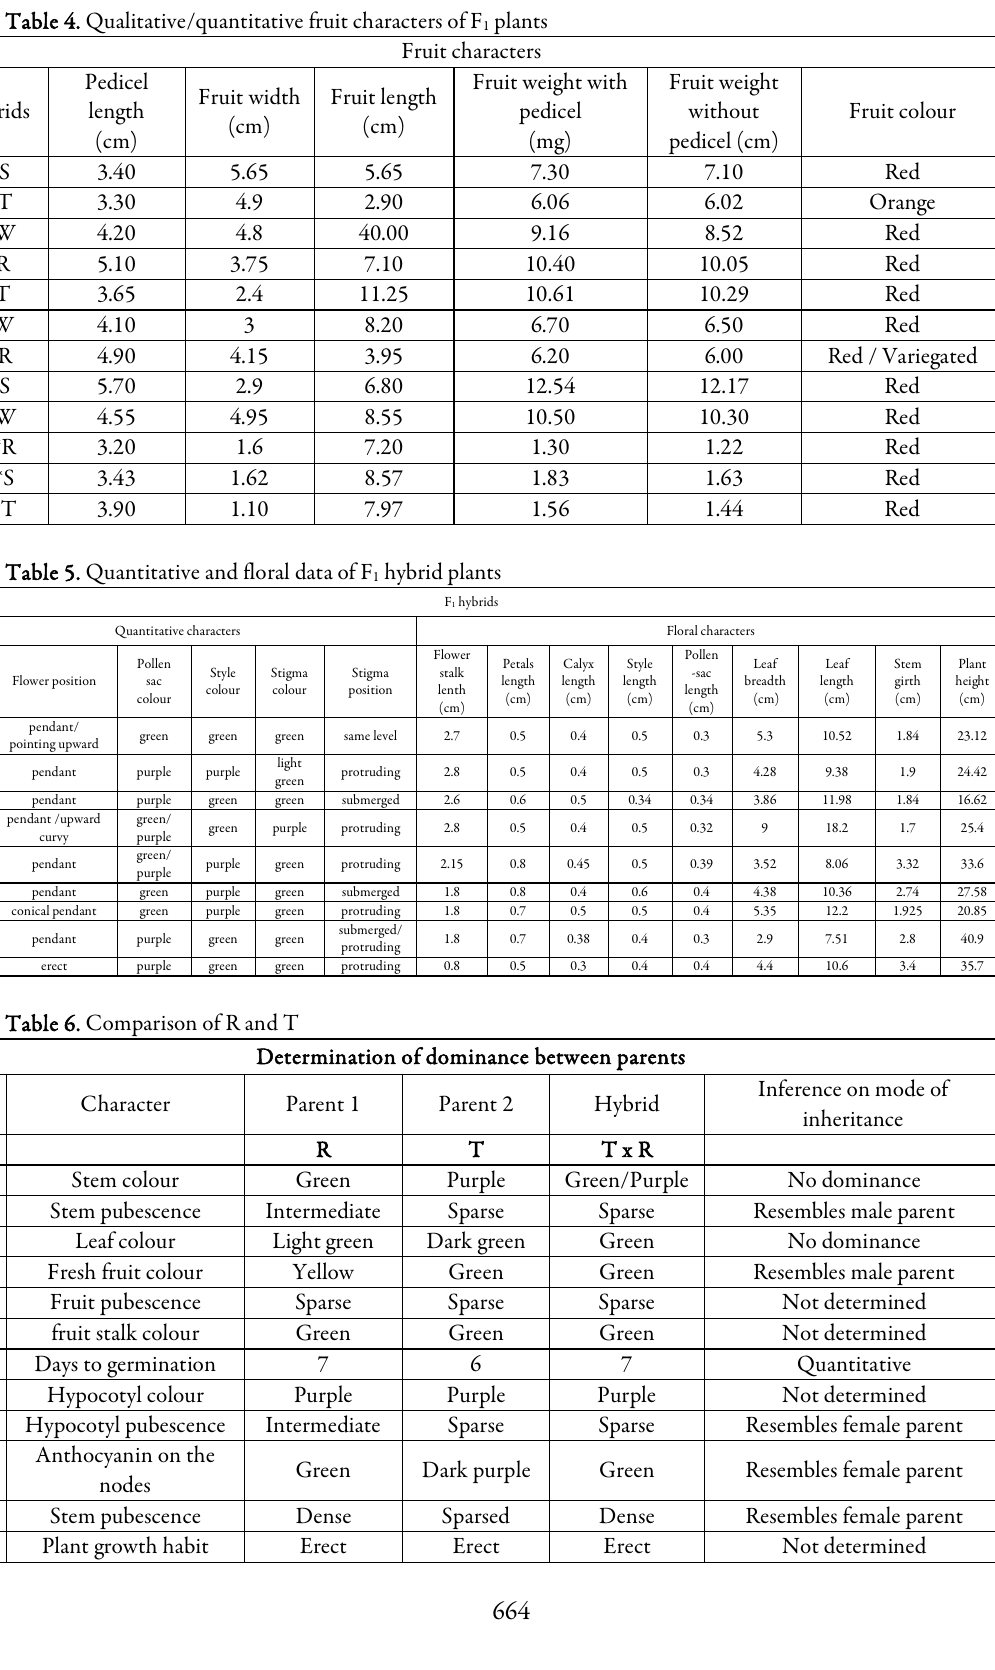
Table 4. Qualitative/quantitative fruit characters of F 1 plants